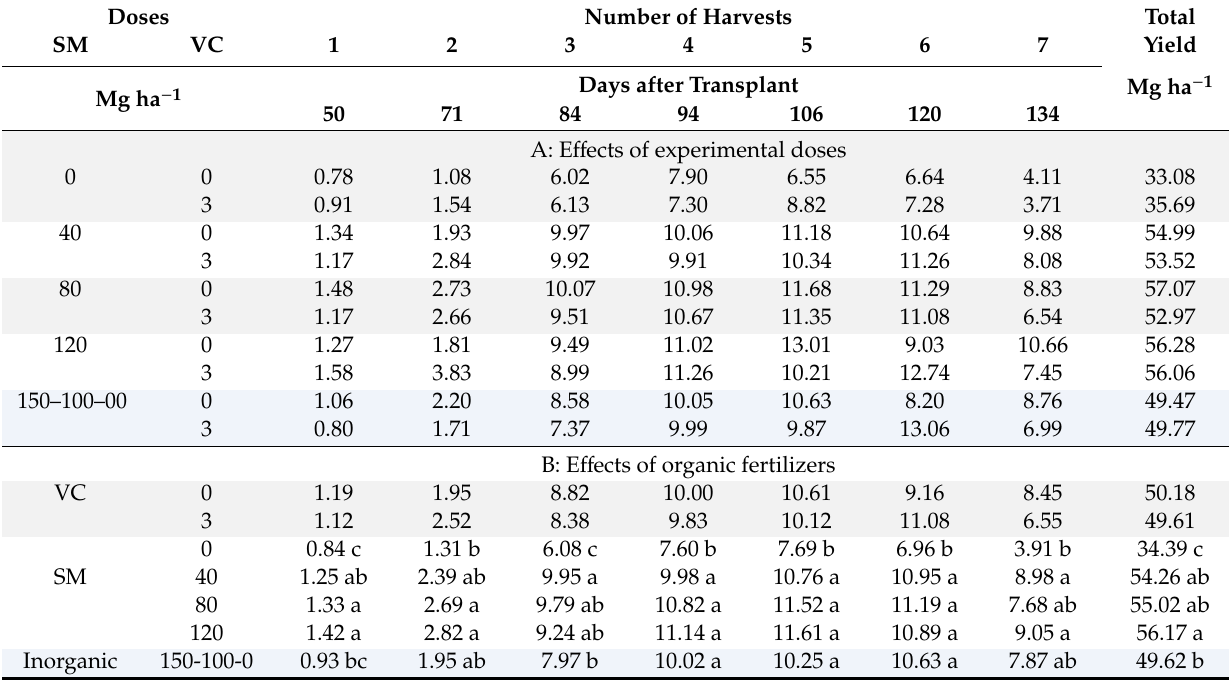
Table 3. A comparison of the yield means for a jalapeño pepper crop in G ó mez Palacio, Durango., Mexico, in seven harvest dates and the total yield; ( A ): E ff ects of the experimental doses, ( B ): E ff ects of the organic